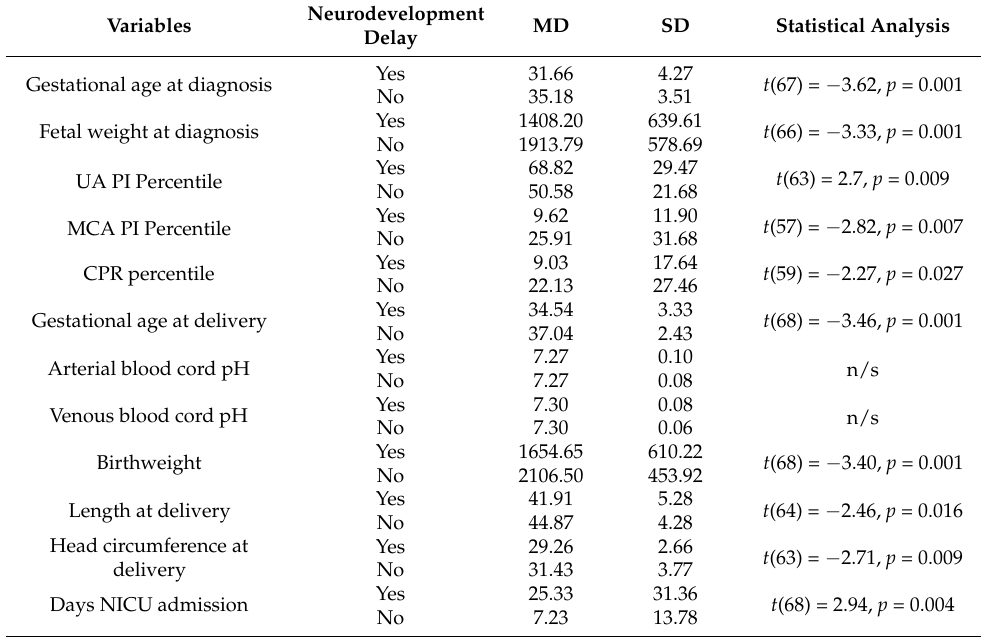
Table 6. Mean values and standard deviations in neurodevelopment delay